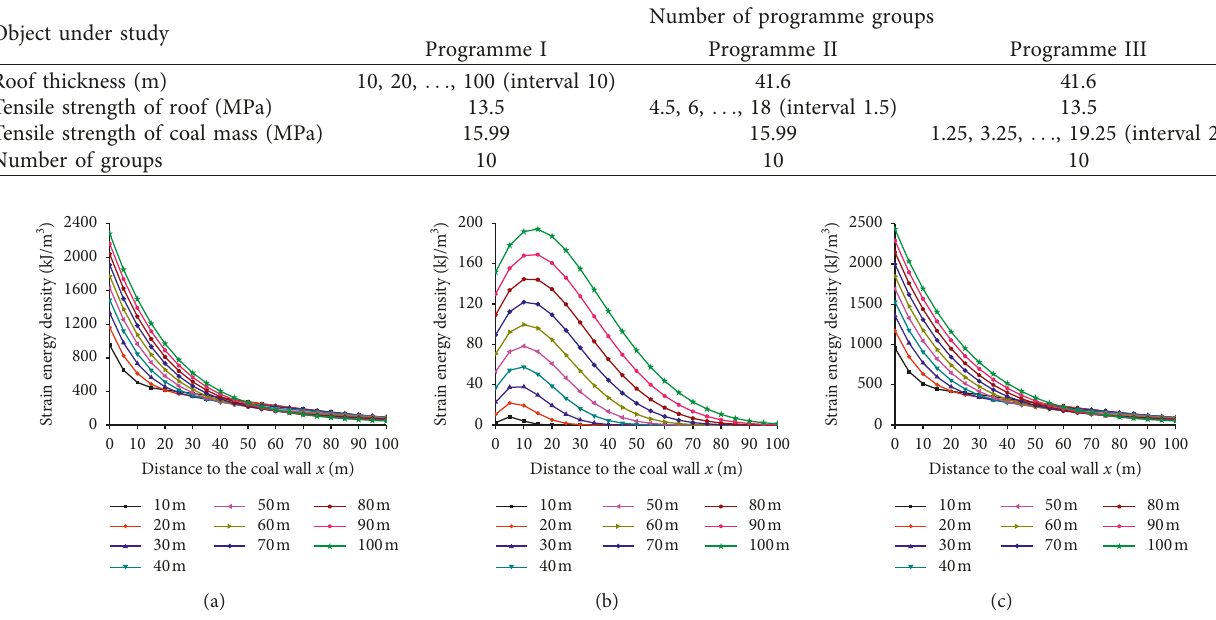
Table 1: Summary of